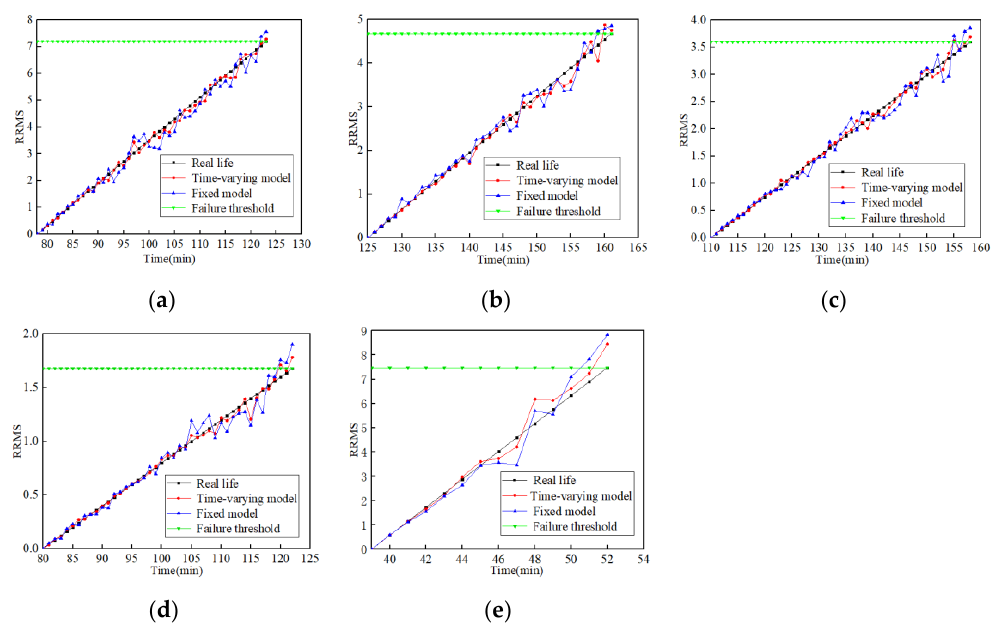
Figure 7 . ( a ) Comparison of RUL prediction of two models for bearing1_1; ( b ) Comparison of RUL prediction of two models for bearing1_2; ( c ) Comparison of RUL prediction of two models for bearing1_3; ( d ) Comparison of RUL prediction of two models for bearing1_4; ( e ) Comparison of RUL prediction of two models for bearing1_5.